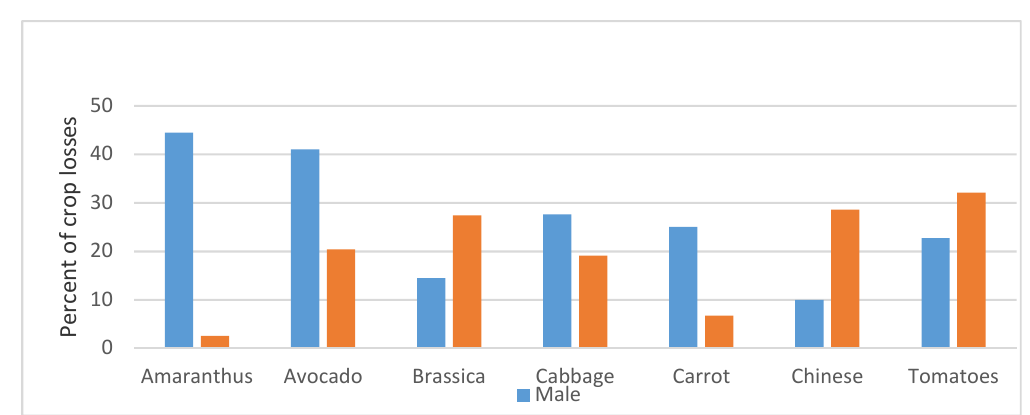
Figure 3. The extent of crop losses in horticultural crops produced by gender .